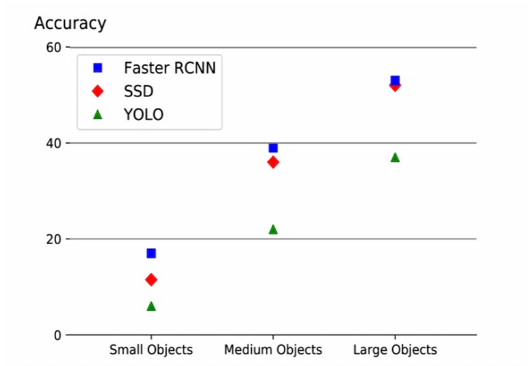
Fig 1 Algorithm’s performance over objects of different sizes.